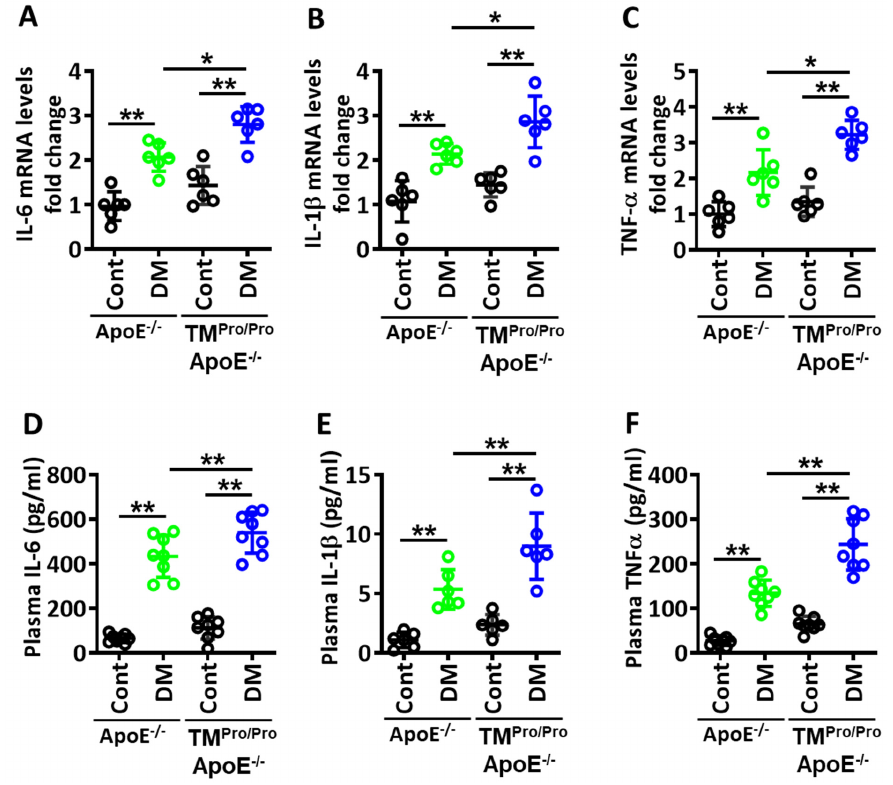
Figure 5. More proinflammatory cytokines in hyperglycemic TM Pro/Pro ApoE -/- versus hyperglycemic ApoE -/- mice . ( A – C ): Dot plot summarizing data for real-time PCR showing aortic expression of IL-6 ( C ), IL-1 β ( D ) and TNF- α ( E ). GAPDH was used as a housekeeping gene. ( D – F ): Dot plot summarizing data for plasma levels of IL-6 ( D ), IL-1 β ( E ) and TNF- α ( F ). ApoE -/- and TM Pro/Pro ApoE -/- control mice (Cont, normal chow diet, citrate instead of streptozotocin injections), ApoE -/- DM mice and TM Pro/Pro ApoE -/- DM (normal chow diet, streptozotocin injections). Each dot represents data obtained from one mouse specimen (n = at least 6 mice per group); ** p < 0.01, * p < 0.05; ns: non-significant; two-way ANOVA.